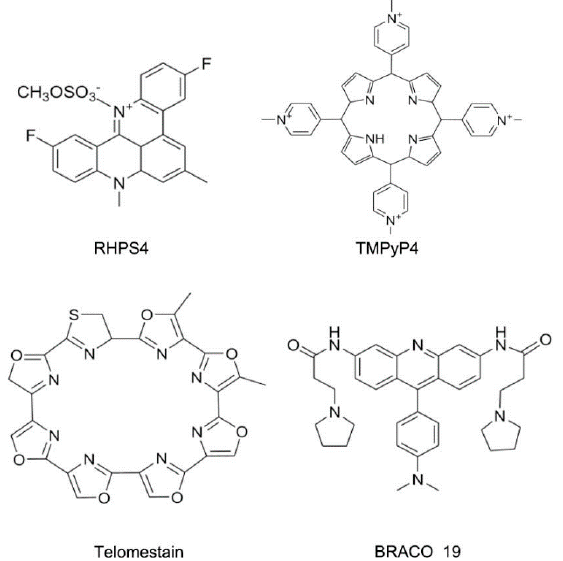
Figure 19. Typical structures of small molecules for DNA quadruplex.